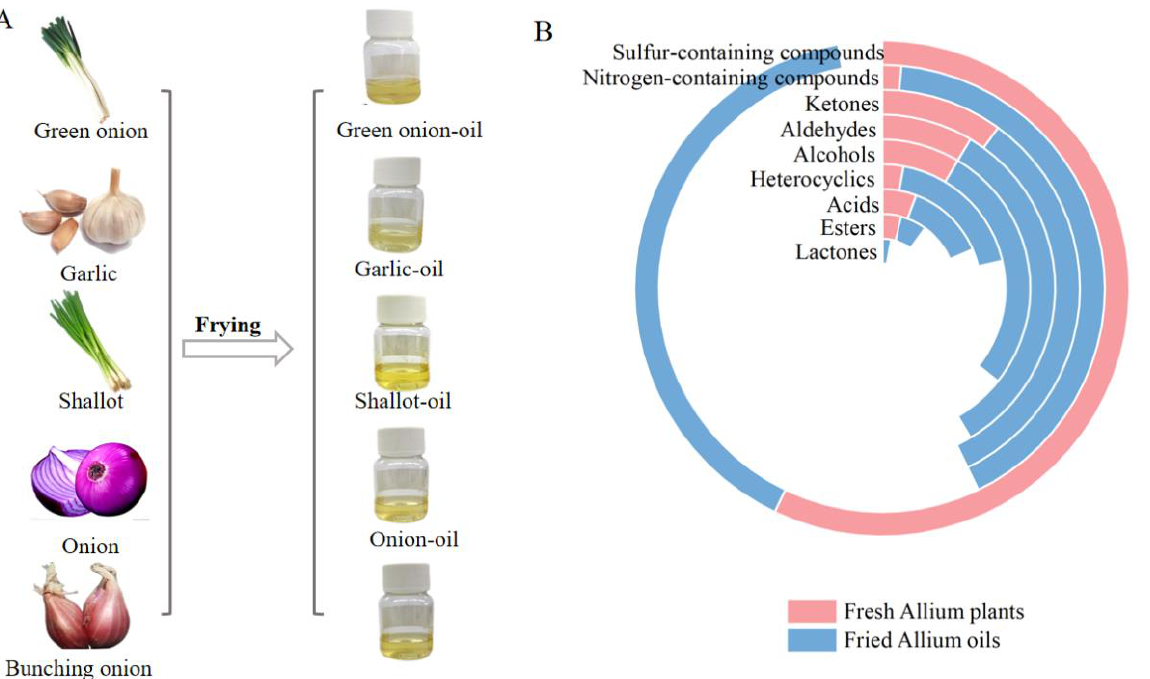
Figure 3. A comparative circular plot of the number of volatile compounds in fresh Allium plants and their fried oils. ( A ) The fresh Allium plants and their fried oils. ( B ) A comparative circular plot. Specific quantities are detailed in Table A5.